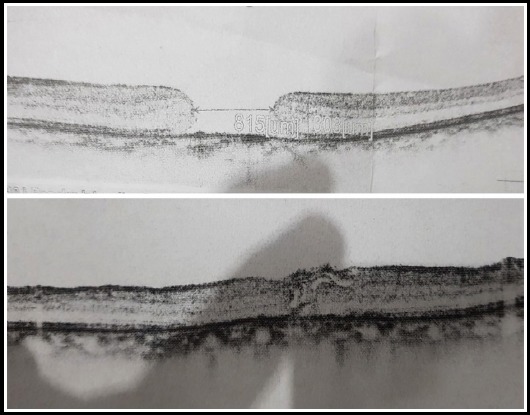
Shows pre-opertaive and post-operative OCTs of macular hole closure with inverted ILM flap.